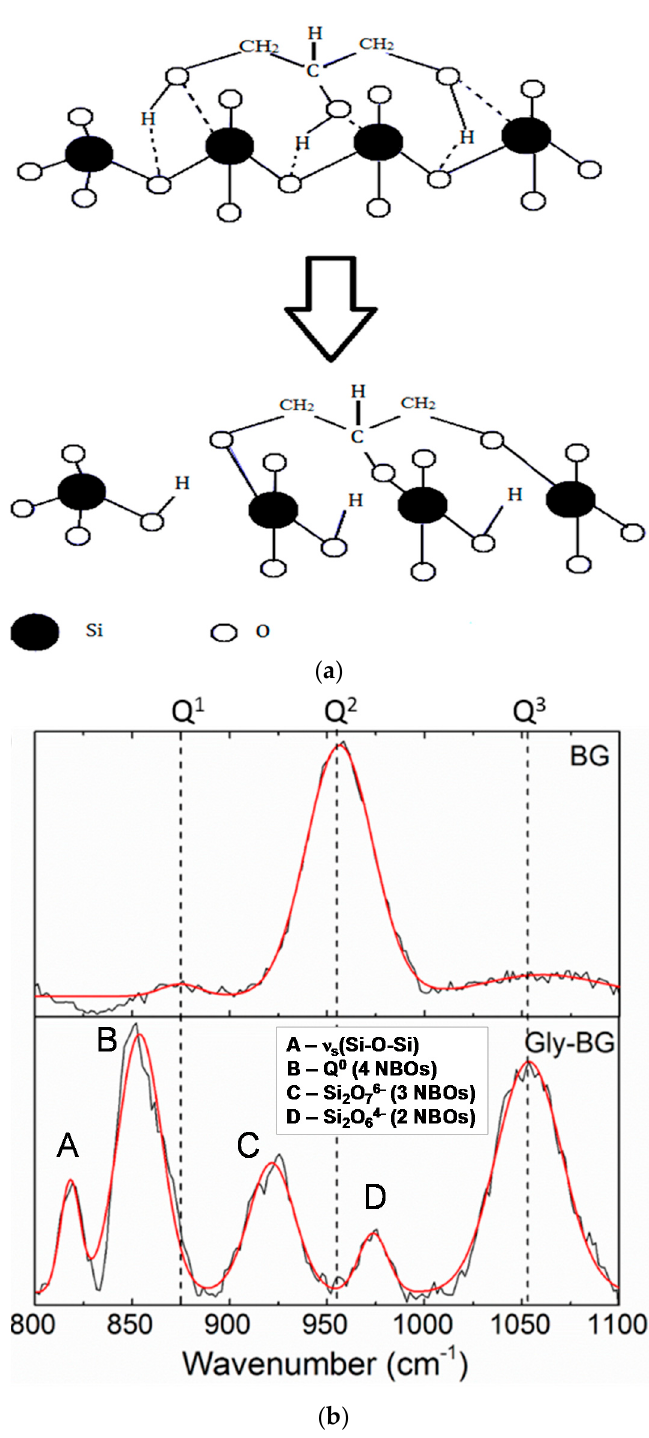
Figure 5. ( a ) Possible interactions of BG with glycerol leading to the decrease of the BG network connectivity and formation of Si–OH groups; ( b ) Raman spectra of BG (top) and BG-gly paste (bottom) [10].